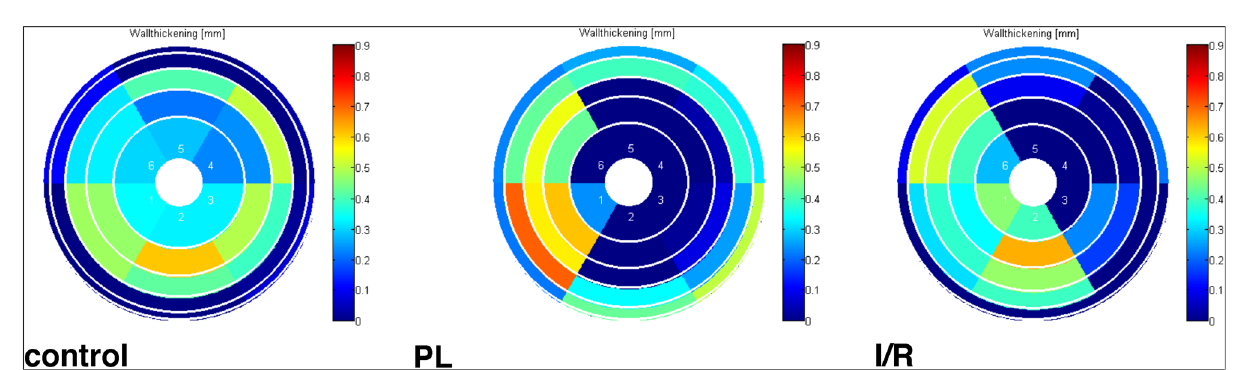
Figure 8. Left ventricular wall thickening. Representative polar maps of visualizing LV wall thickening of healthy (control) and MI